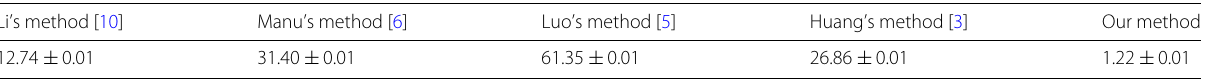
Table 3 Running time (seconds) for different methods on a 321 × 481